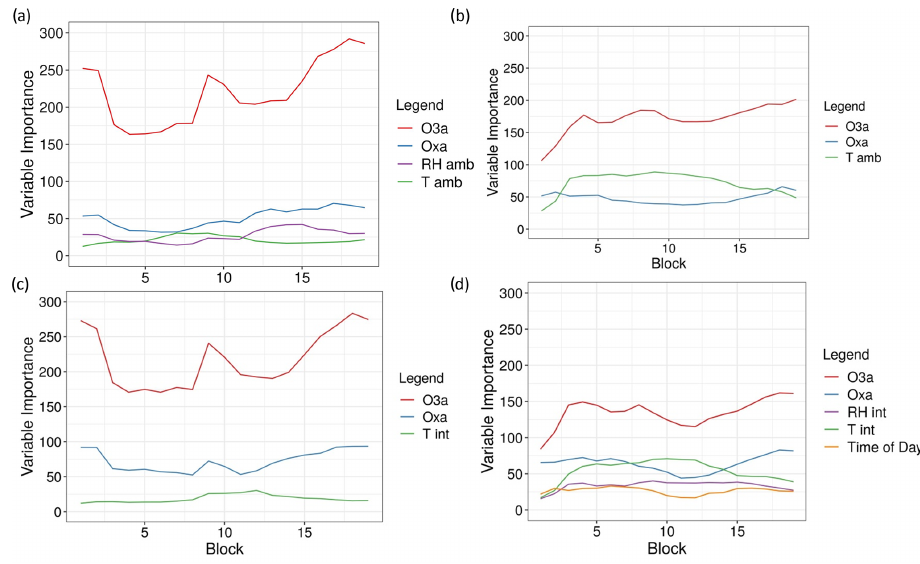
Figure 10. Variable importance over the 19 test blocks of (a) model 2a, (b) model 4a, (c) model 2b, and (d) model 4b. Table 8. Results of RF and MLR models for NO 2 trained with co-location 2, co-location 3, or a combination of both when tested on the comparison experimental dataset. In the lower half of the table, the models are trained with the same datasets but are tested on the experimental dataset with data points outside the ranges of each training dataset filtered out. The most accurate model is in bold. NO